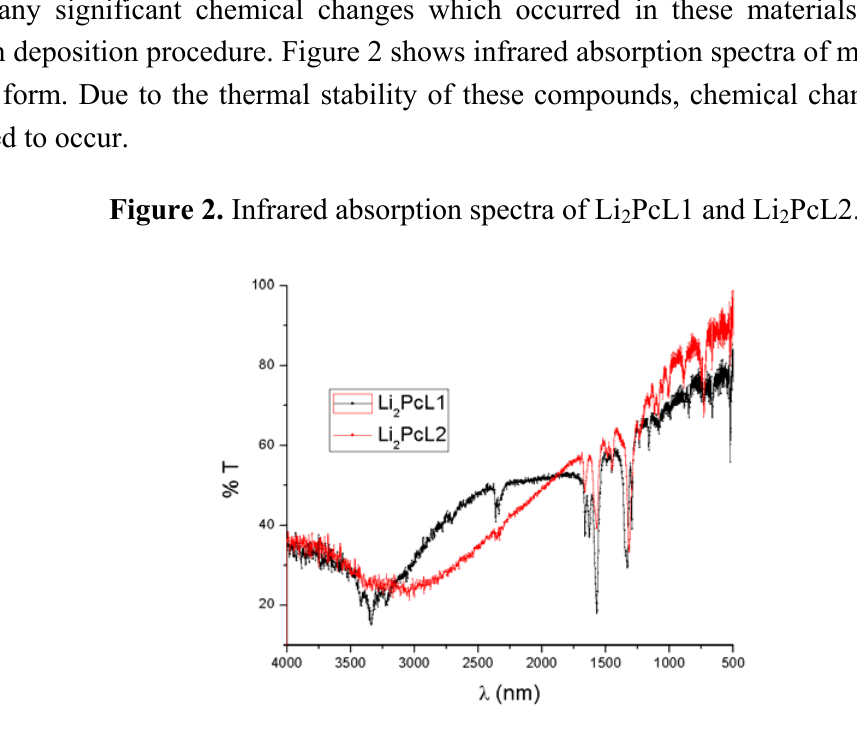
Figure 2. Infrared absorption spectra of Li